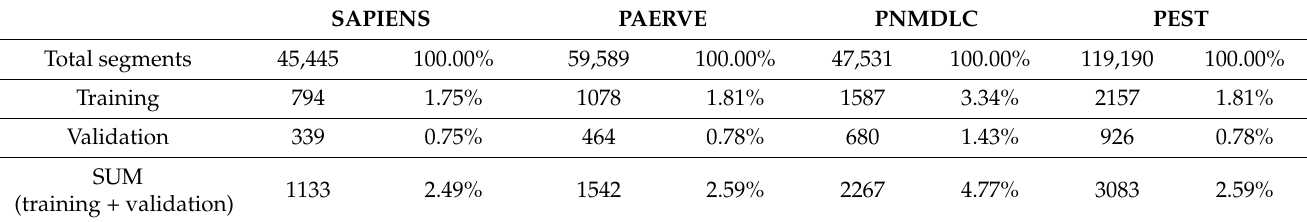
Table 2. Number of segments selected for training and